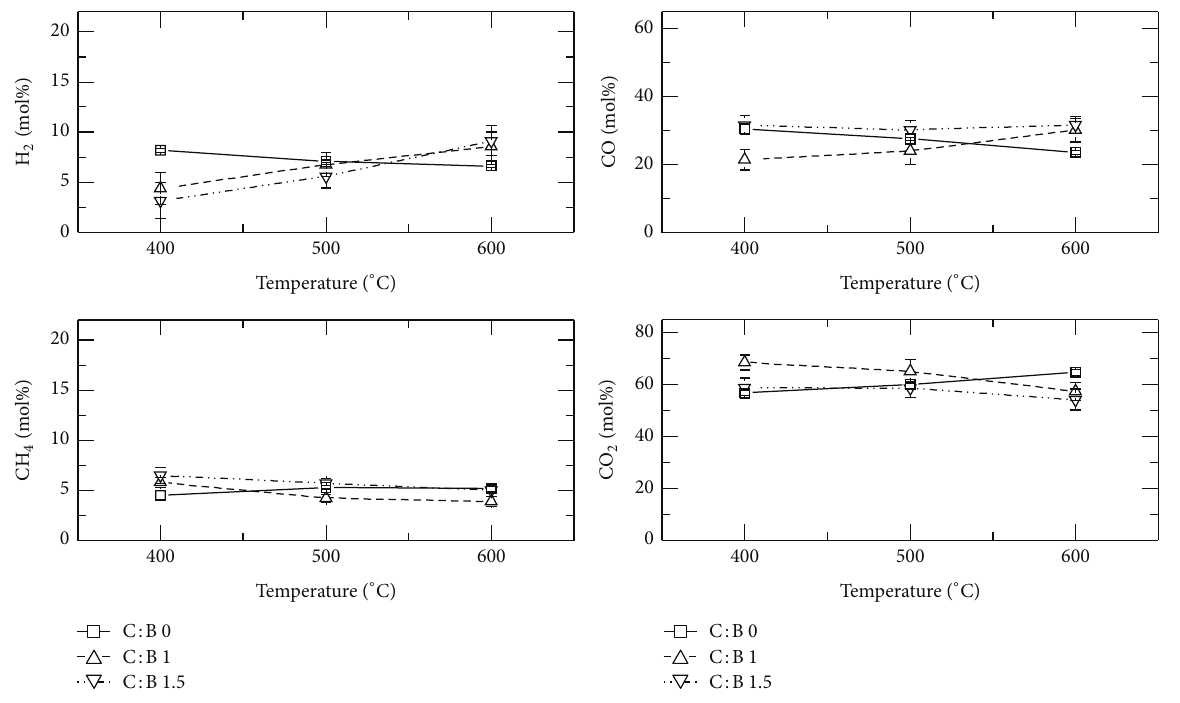
Figure 4: Effect of catalyst ratio on gas composition at different temperatures.